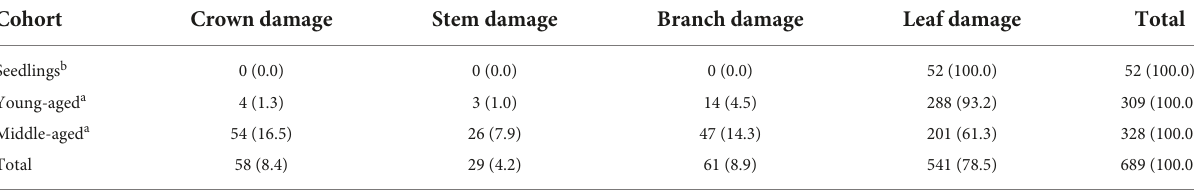
TABLE 1 Damage type by cohort in the cold spell impacted zone (Xiangshan county) of March